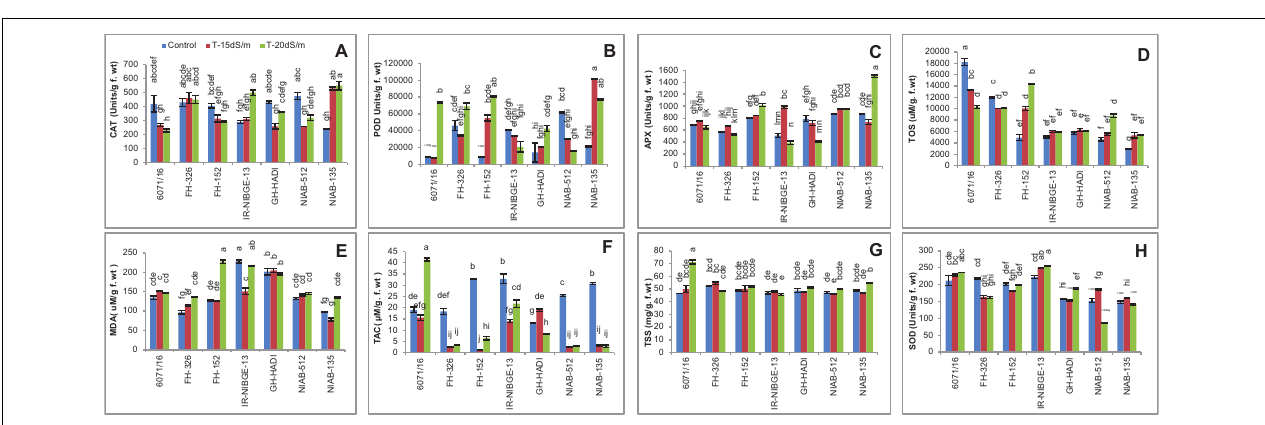
FIGURE 11 | Comparison of panels (A) lycopene, (B) chlorophyll a, (C) chlorophyll b, (D) total carotenoids, (E) total chlorophyll, (F) total phenolic content, (G) tannins, (H) total flavonoids, (I) ascorbic acid, (J) total soluble proteins, (K) reducing sugars, and (L) amylase in cotton genotypes under stress and non-stress conditions.